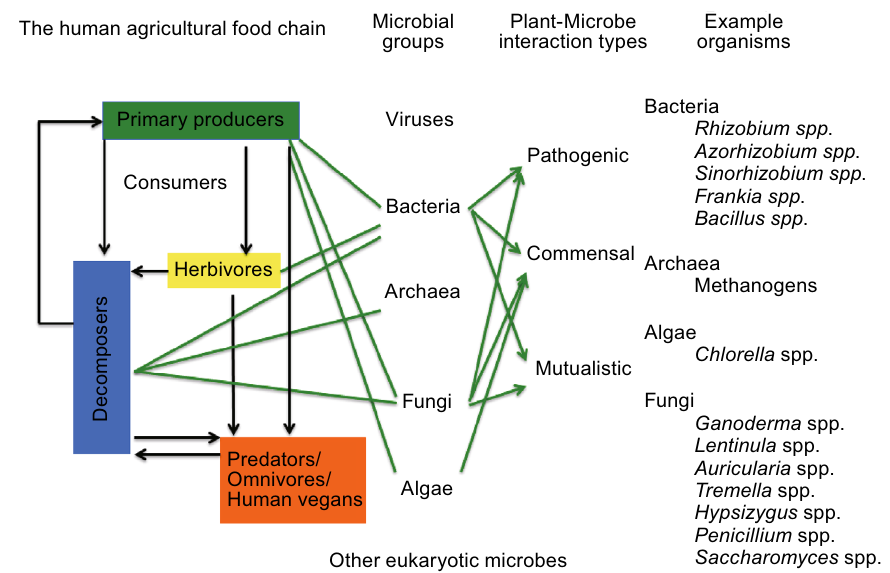
Figure 2. A microbe-centric summary of Dr. Fan Qingsheng ’ s work on agricultural microbes and their roles in the broad systems agriculture framework . Example organisms that Dr. Fan worked on are shown on the right. These microorganisms were investigated for their potential roles in enhancing crop productivity (e.g. Rhizobia ), reducing diseases (e.g. Penicillium and Streptomyces ), eliminating and/or bio-converting agricultural wastes into valuable goods (e.g. methanogens and edible fungi), and enhancing soil fertility (legumes and Rhizobia